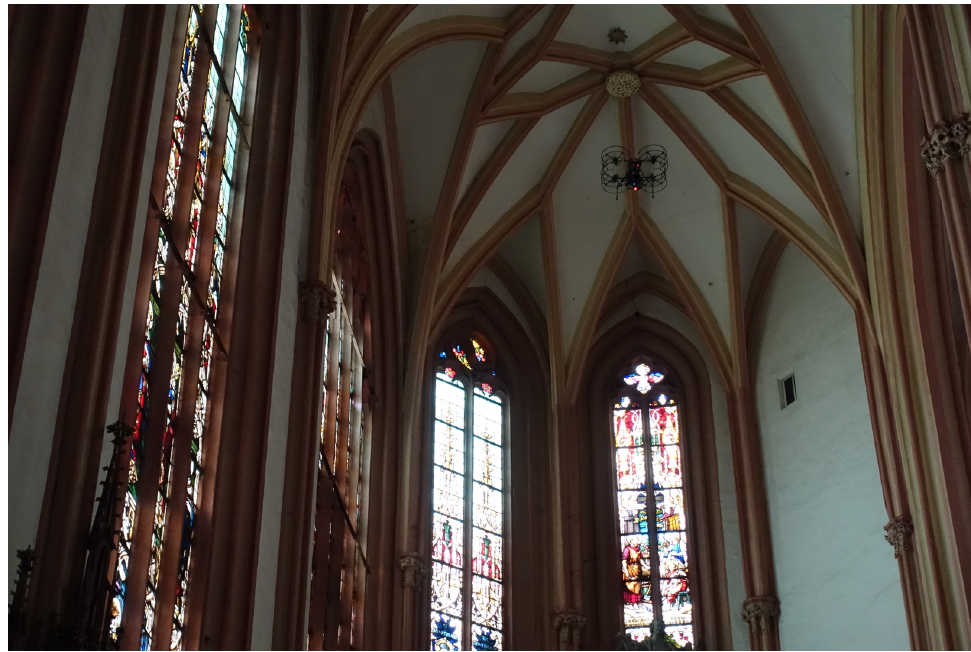
Figure 9. Proposed unmanned aerial vehicle system during the documentation of stained glasses in the nave of St. Maurice